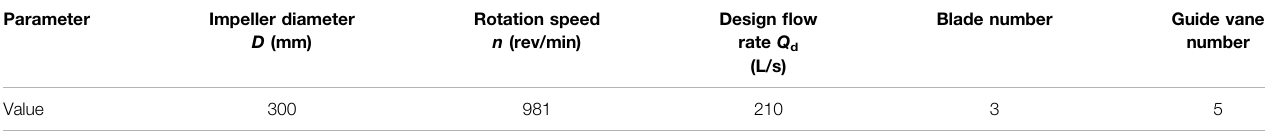
TABLE 1 | Main design parameters.